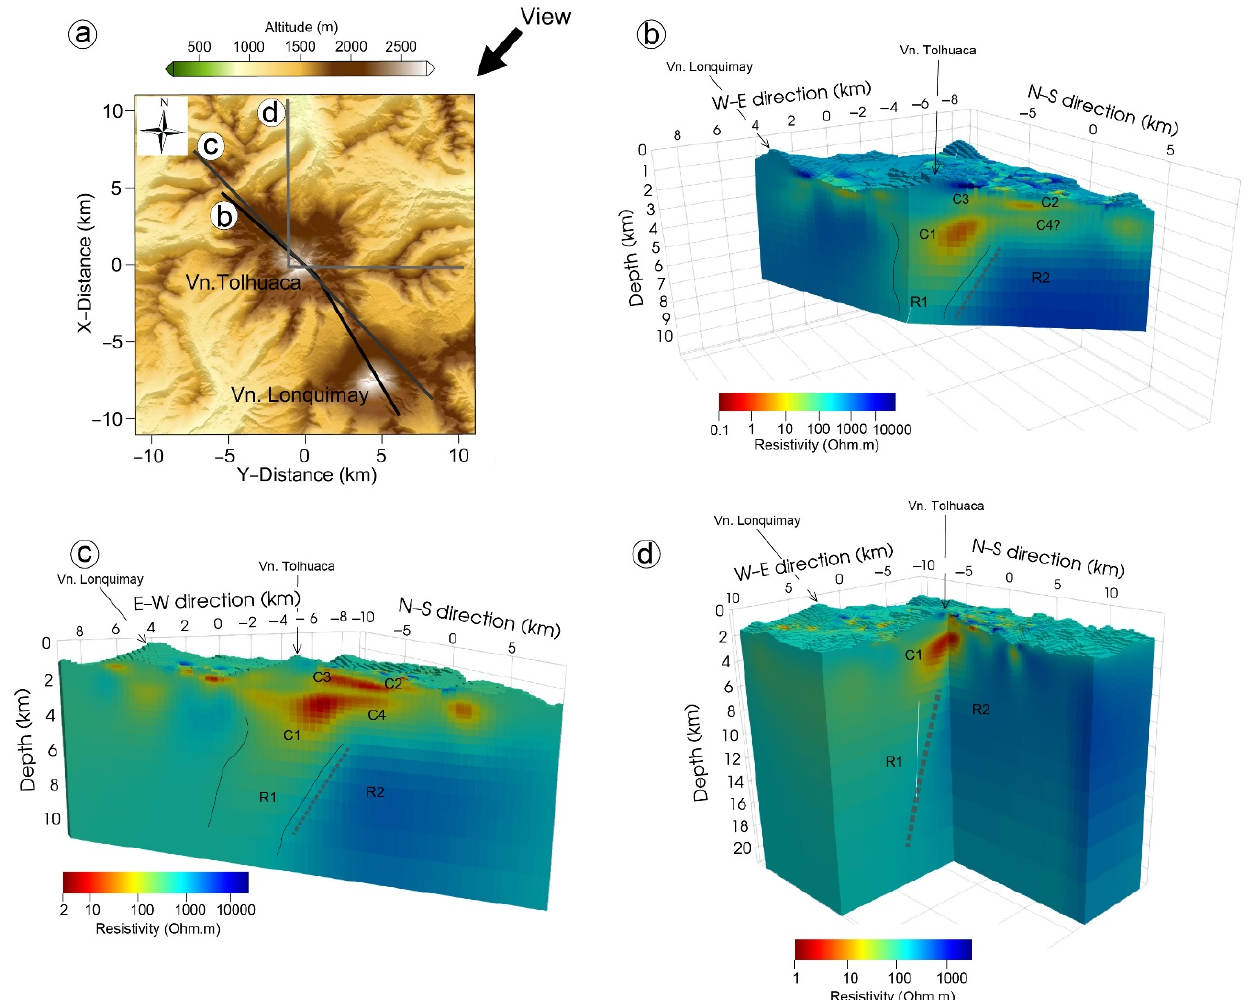
Figure 7. ( a ) Topographic map including three vertical slices of the preferred 3D MT model. High altitudes correspond to the summit of volcanoes. ( b ) Multi-segment cross-section through the wells and major volcanoes are shown in Figure 5. ( c ) NW-SE cross-section magmatic and hydrothermal fluid pathways. ( d ) Three-dimensional 3D resistivity image derived from N-S and E-W orthogonal profiles in order to the inferred position and extension of the crustal long-term magmatic storage denoted by C1.